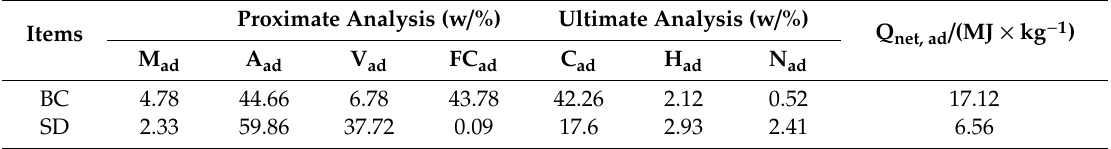
Table 1. Proximate and ultimate analysis of the sludge and coal.